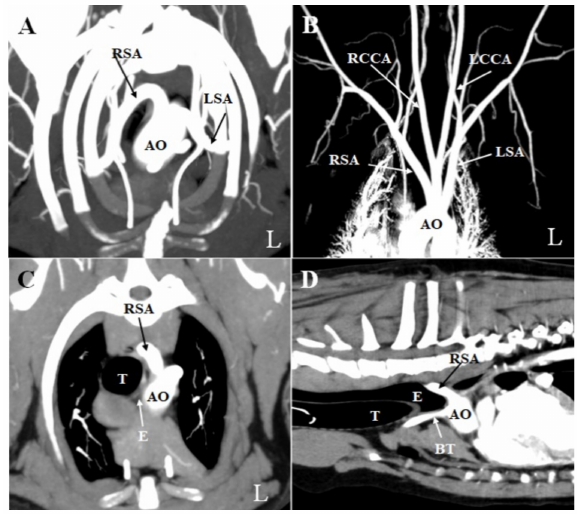
Figure 2. Pre-operative computed tomographic angiography images. ( A ) Multiplanar reconstruction of the transverse image. ( B ) Multiplanar reconstruction of the coronal image (bone deleted). An anomalous right subclavian artery that originated from the aortic arch at the same location as the left subclavian artery to the left of the trachea was identified. It then coursed cranially and obliquely toward the right forelimb, passing dorsally to the esophagus. ( C ) Transverse image at the level of the junction between the anomalous right subclavian artery and the aorta. The esophagus was constricted between the right subclavian vessel dorsally and bilaterally, and the trachea ventrally. ( D ) Sagittal image of the thorax. The esophagus located before the anomalous right subclavian artery was expanded. AO: aorta; BT: brachiocephalic trunk; E: esophagus; L: left; LCCA: left common carotid artery; LSA: left subclavian artery; RCCA: right common carotid artery; RSA: right subclavian artery; T: trachea.